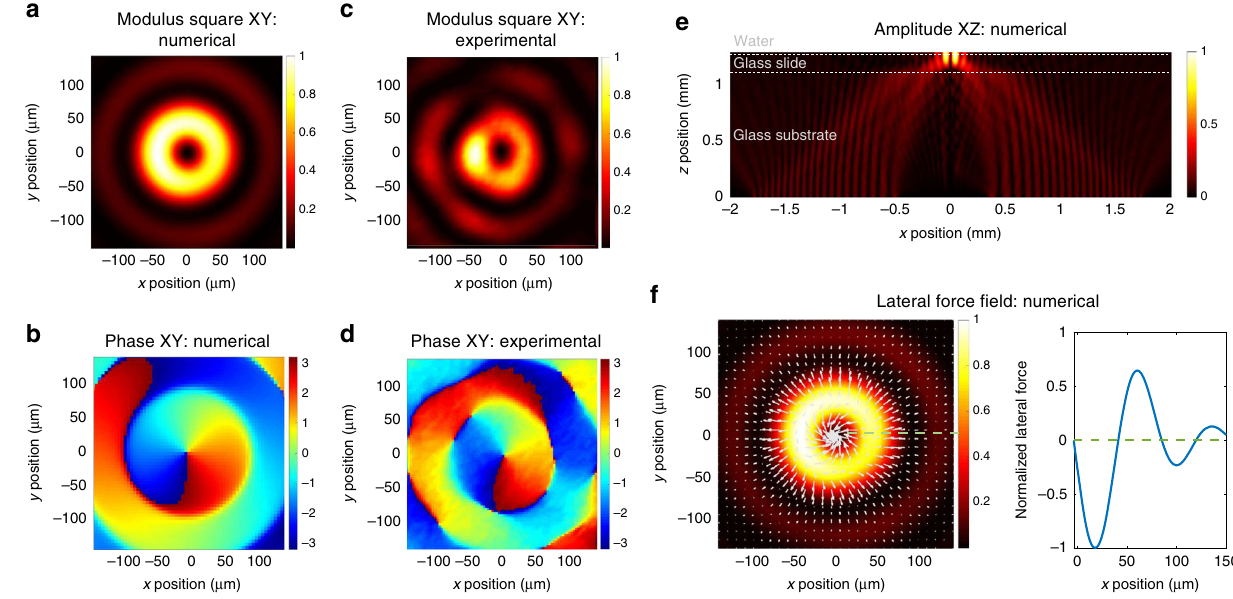
Fig. 2 Acoustic fi eld and radiation forces. a – d Numerical predictions ( a , b ) and experimental measurements ( c , d ) with a UHF-120 Polytec laser Doppler vibrometer of the normalized modulus square ( a , c ) and phase ( b , d ) of the acoustic normal displacement at the surface of the glass slide ( XY plane). The displacement magnitude is normalized by its maximum value measured to lie between 0.1 and 1 nm depending on the electrical power applied to the transducers. e Simulated evolution of the amplitude of the acoustic fi eld in the propagation plane ( XZ ) from the source to the center of the channel. This simulation illustrates the concentration of the acoustic energy through focalization. f Normalized magnitude and distribution of acoustic forces. Left: the white arrows show the convergence of the force fi eld toward the center of the beam but also that the fi rst ring is repulsive for particles located outside the trap. Right: Magnitude of the lateral force along the green dashed line plotted in the left fi gure. When the force is negative, the particle is pushed toward the center of the acoustic vortex, while when it is positive it is pushed outward. Zero values correspond to static equilibrium positions. The magnitude of the maximum trapping force computed with the code varies between 30 and 650 pN (see “ Methods ” section “ Simulations of the acoustic fi eld and radiation force ” ) for vibration amplitude of 1 nm (acoustic power of 2 mW) depending on the exact cells acoustic properties 42, 43 force also show that as long as a cell is located at a distance of ≤ 40 μ m from the center of the vortex, it is attracted toward the center of the beam (the lateral force is negative). This distance corresponds approximatively to the fi rst ring radius and de fi nes the spatial selectivity of the tweezers.